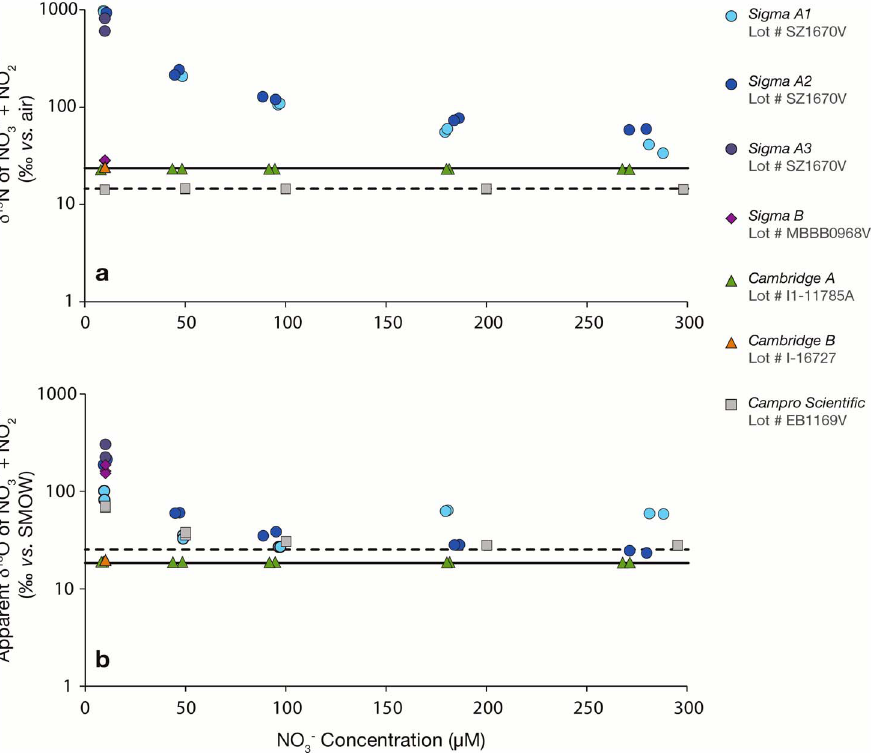
Figure 1. ( a ) d 15 N NO3 + NO2 (log scale) of nitrate solutions (10–300 m mol L 2 1 ) following equilibration with 0.1 mL 15 N 2 gas from lecture bottles procured from three distributors. Solutions were 40 mL for Sigma-Aldrich and Campro Scientific equilibrations, and 100 mL for Cambridge Isotopes equilibrations. The solid line corresponds to the d 15 N NO3 of the control solutions for Sigma-Aldrich and Cambridge Isotopes experiments ( d 15 N NO3 =23.5 6 0.5 % ); the dashed line corresponds to controls for Campro Scientific experiments ( d 15 N NO3 =14.15 6 0.1 % ). Paired symbols identify replicate experimental treatments. ( b ) Corresponding apparent d 18 O NO3 + NO2 of the experimental nitrate solutions. The solid line corresponds to the d 18 O NO3 of control solutions for the Sigma-Aldrich and Cambridge Isotope experiments ( d 18 O NO3 =18.9 6 0.3 % ); the dashed line corresponds to controls for Campro Scientific experiments (25.4 6 0.3 % ).